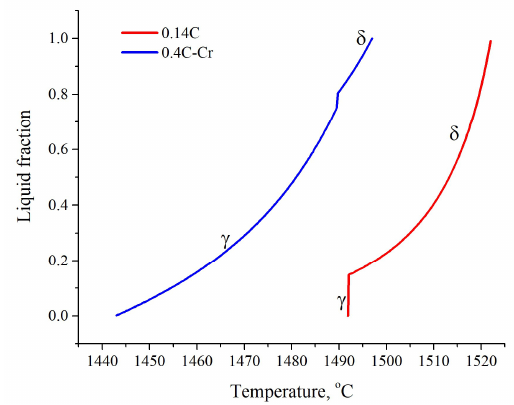
Figure 2. The influence of temperature on the liquid steel fraction (by ThermoCalc).